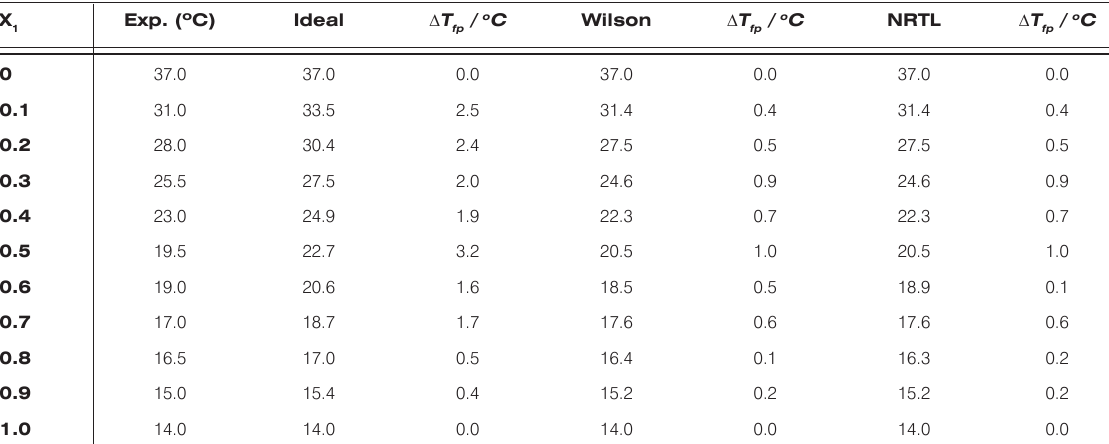
Table 5. Experimental flash points and predictions for 4-methyl-2-pentanone (1) +1-butanol